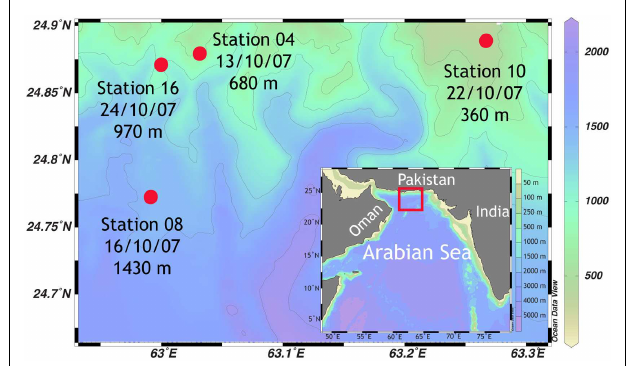
FIGURE 1 | Sampling area of the R/V Meteor cruise M74/2 in October 2007, in the Makran region at the Pakistan continental margin. Color scale on the right denotes water